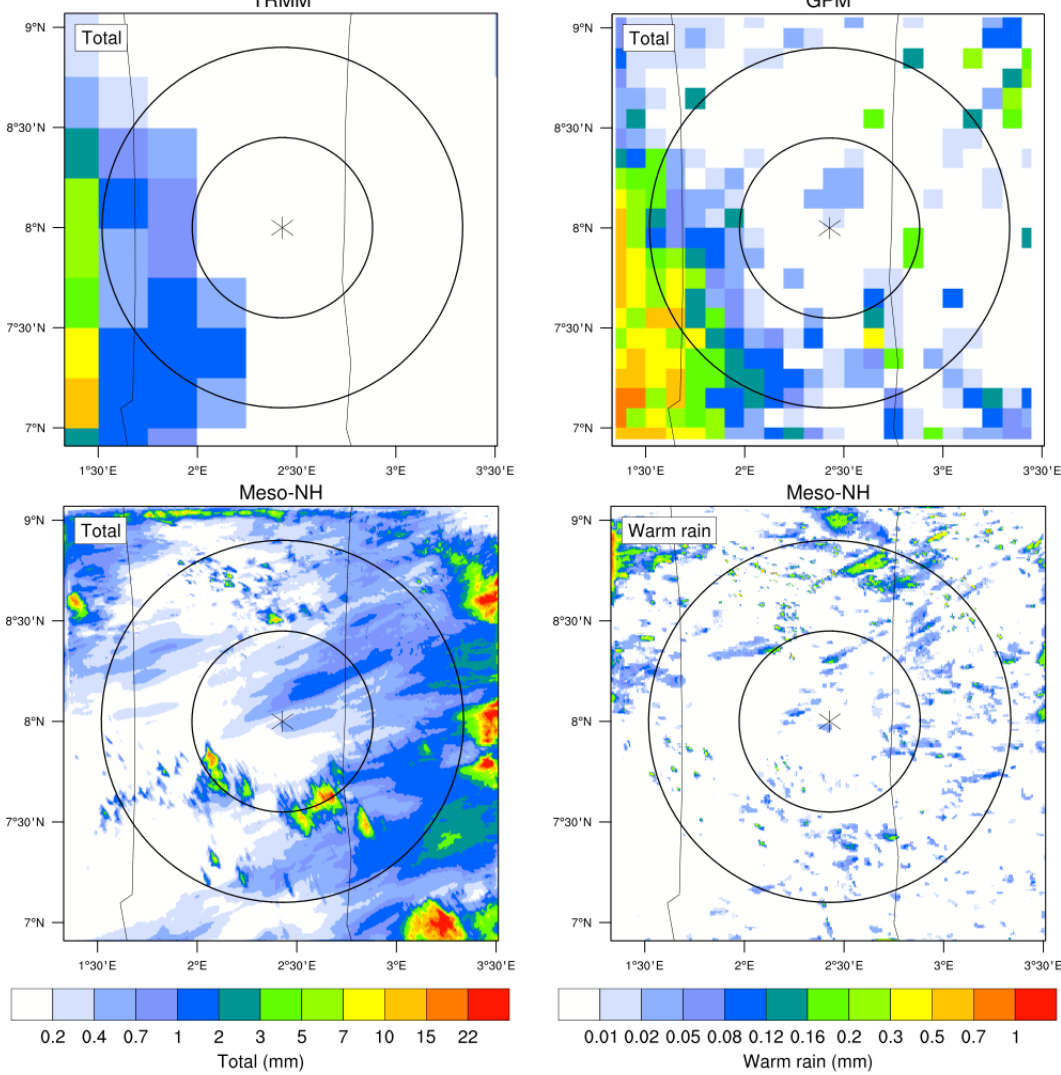
Figure 6. Maps of total accumulated rainfall from 03:00 to 09:00 UTC, for TRMM, product 3B42V7 ( top left ); for GPM, product IMERGV06B ( top right ); for Meso-NH ( bottom left ) and for Meso-NH but only the accumulated warm rain ( bottom right ). Note that the labels of the colorbars differ between the maps of total and warm